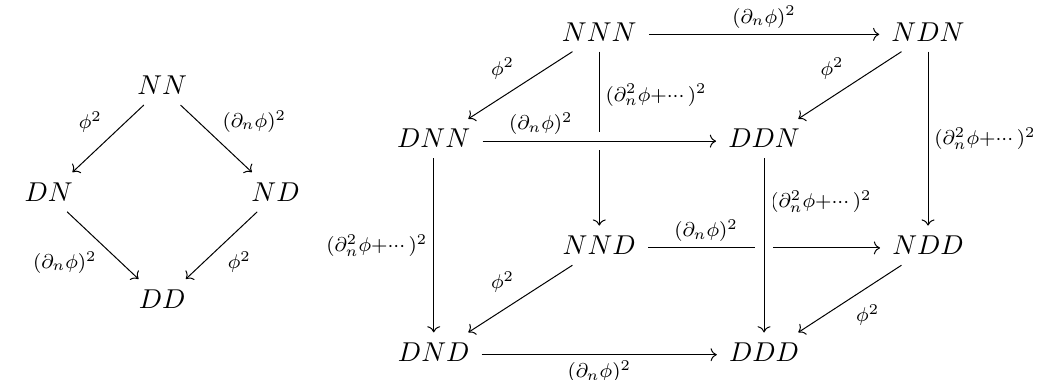
Figure 1 . Some of the boundary RG flows induced in the k = 2 system (left) and k = 3 system (right). There are additional flows, not shown, along the diagonals of the square and the diagonals of the faces of the hypercube, induced by c Φ ( k,q ) Φ ( k,q 0 ) , q 6 = q 0 , type